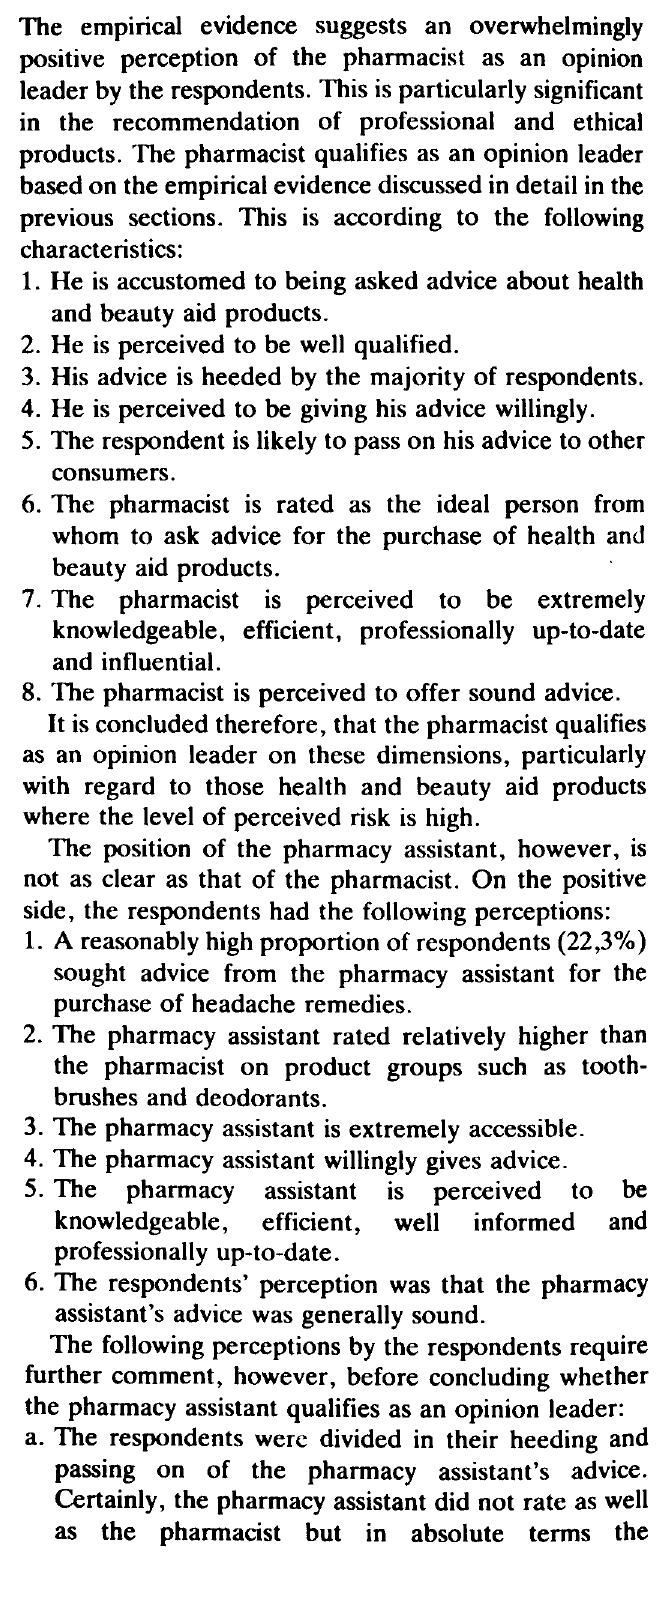
Table 11 The image of the pharmacy assistant as